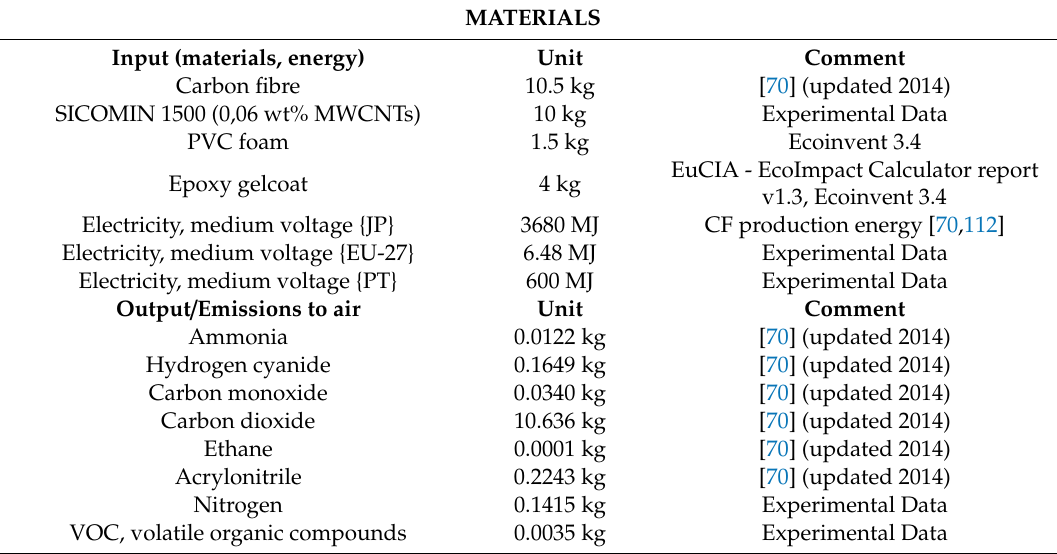
Table A2. LCI of 1-piece (26 kg) ‘Sleekfast’ sailing